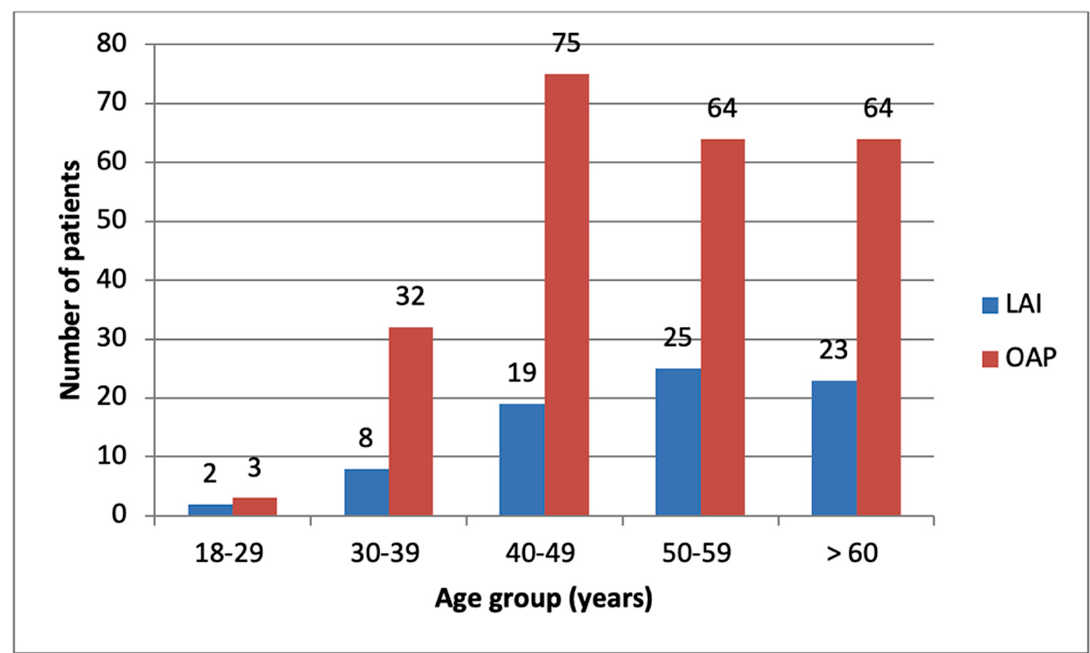
Figure 1. Age group distribution of LAI and OAP groups.